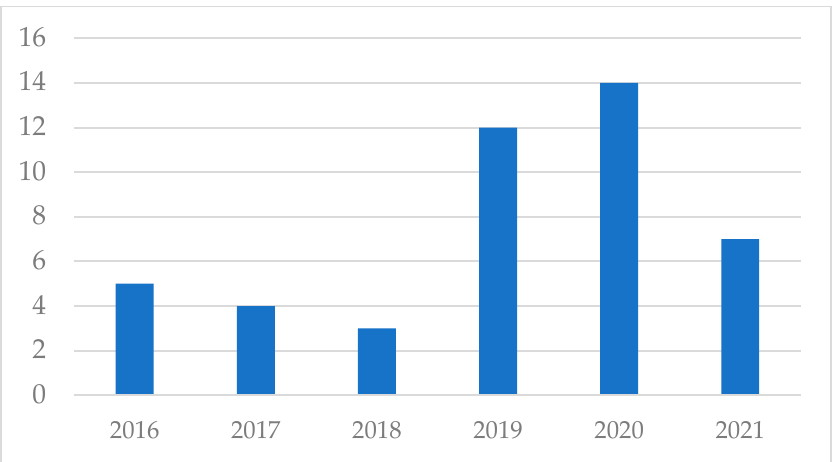
Figure 2. Amount of papers by year of publication.